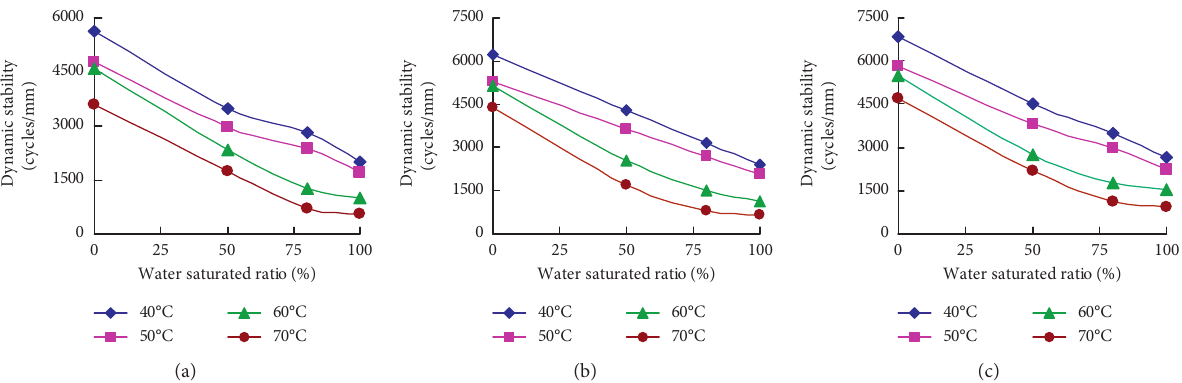
Figure 3: Relationship between dynamic stability and saturated water ratio at different temperatures. (a) 1% content. (b) 2% content. (c) 3% content.